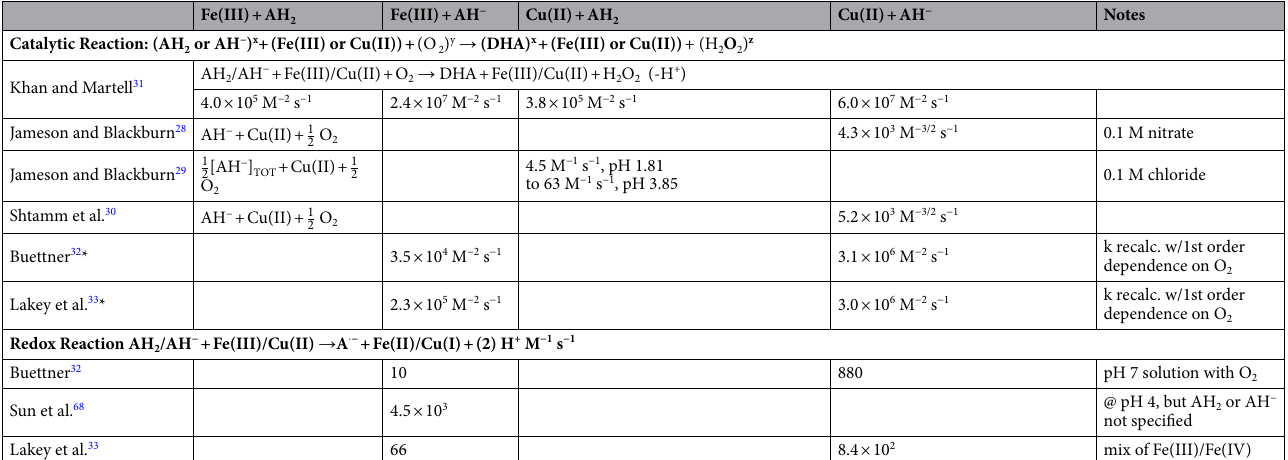
Table 3. Summary of rate constants for reactions of iron and copper with ascorbic acid. *The reaction appears to be catalytic, but these papers assumed a redox reaction; the rate has been recalculated here assuming an oxygen